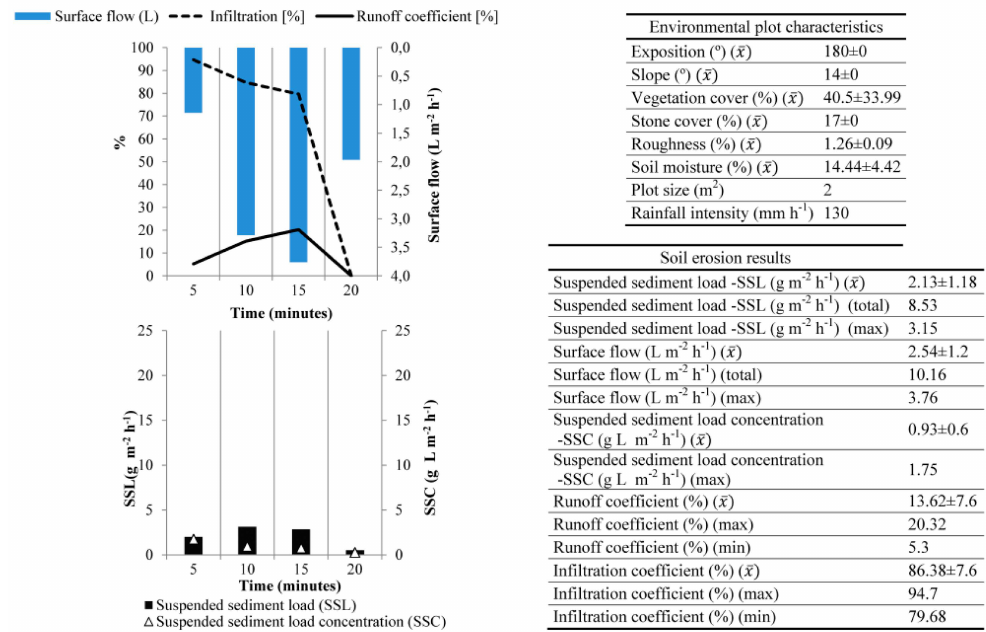
Figure 8. Rainfall simulations in Campo Real (Madrid, Spain).